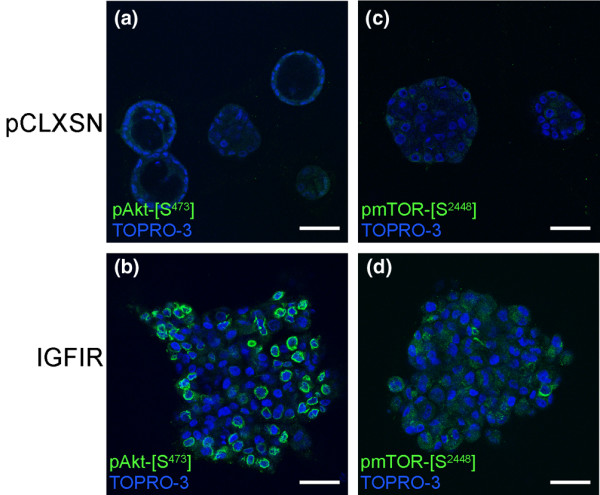
Induction of Akt signaling in IGFIR structures. Equatorial confocal sections of 34-day control (pCLXSN, panels a, c) and IGFIR acinar structures (panels c, d) labeled with phosphospecific antibodies to Akt- [S473] (green; panels a, b) and mammalian target of rapamycin (mTOR)- [S2448] (green; panels c, d) and the nuclear counterstain TO-PRO-3 (blue). Scale bars = 50 μm.